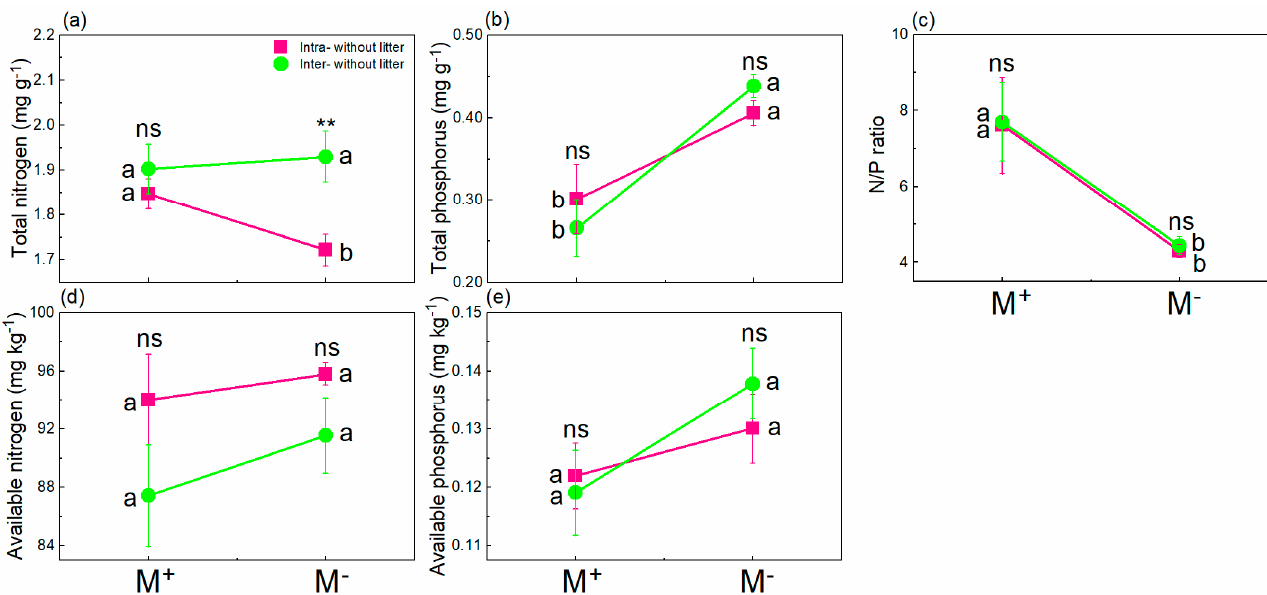
Figure 5. The soil nutrient properties on the total nitrogen and phosphorus ( a , b ) and the N/P ratio ( c ) and the available nitrogen and phosphorus ( d , e ) in two competition soils through AM fungus under none − litter addition treatment. Abbreviations: see Figure 2 for explanations of M + , M − , Intra − , Inter − and **, the lowercase letters (a,b) and the ns.